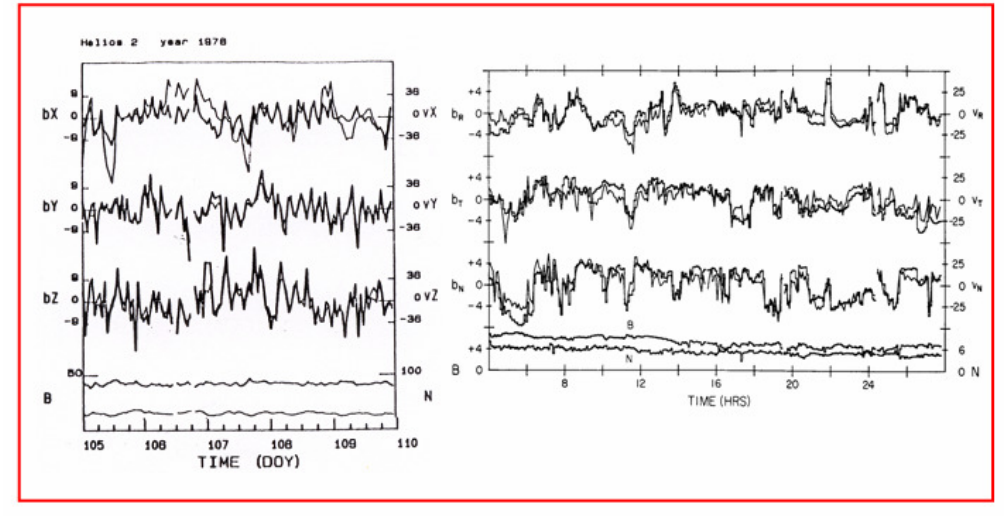
Figure 36: Alfv´enic correlation in fast solar wind. Left panel: large scale Alfv´enic fluctuations found by Bruno et al. (1985). Right panel: small scale Alfv´enic fluctuations for the first time found by Belcher and Solodyna (1975). Image reproduced by permission, copyright by